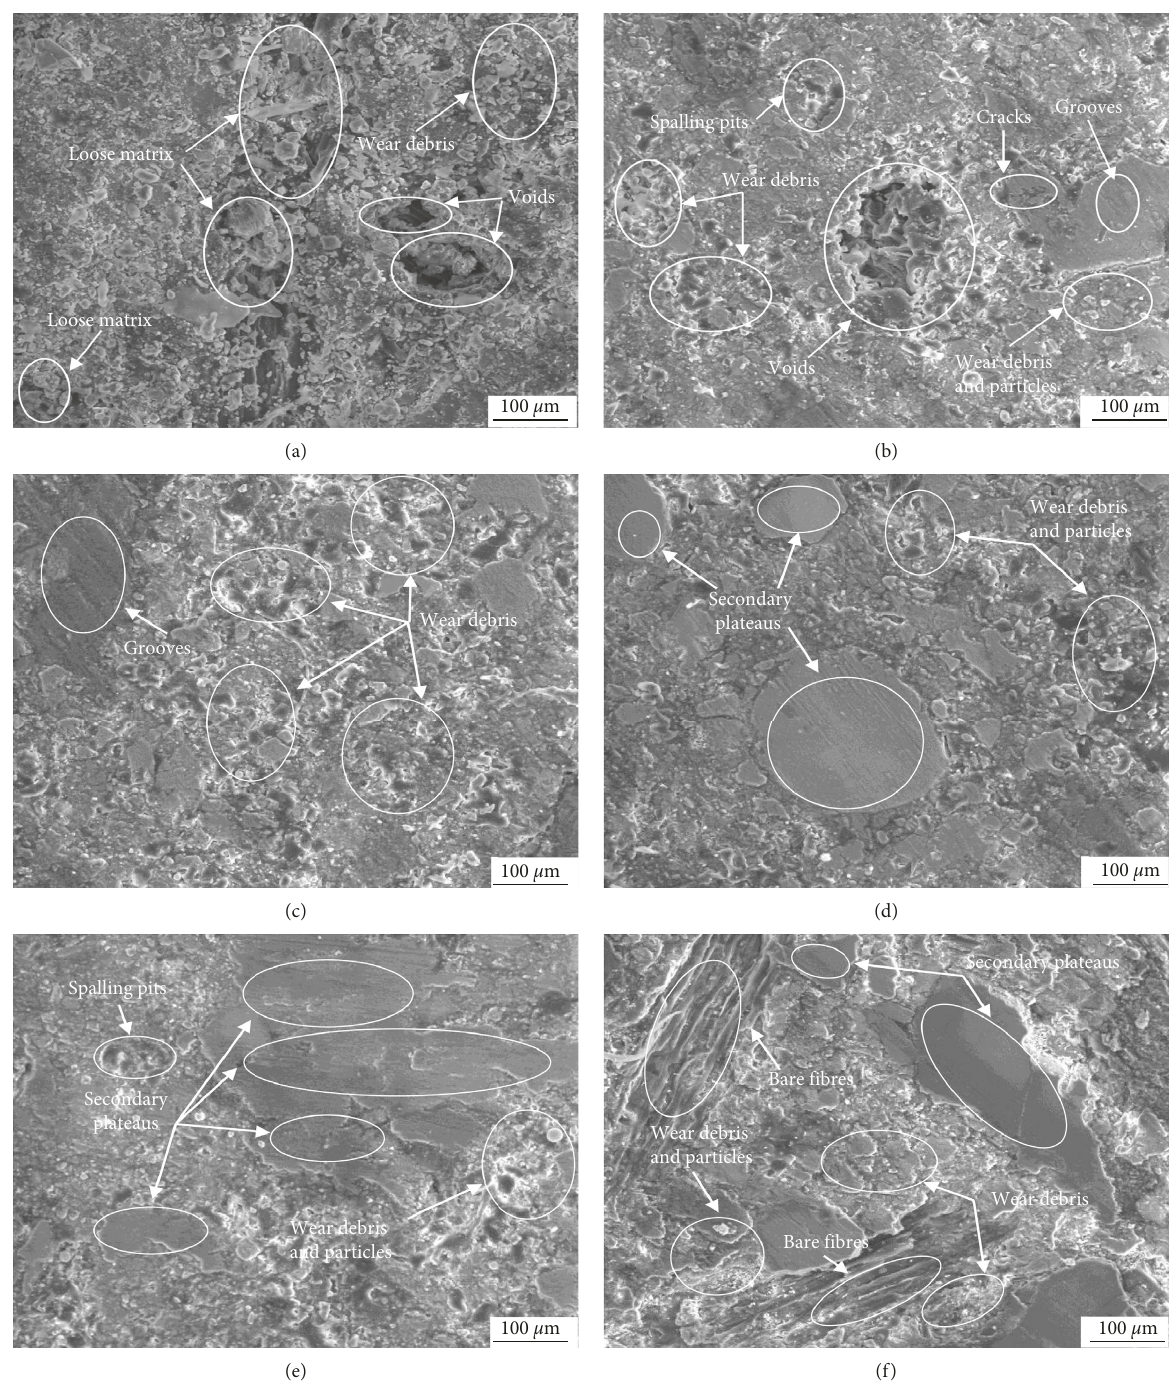
Figure 10: Worn surface micrographs of the composites. (a) FM-0. (b) FM-1. (c) FM-3. (d) FM-5. (e) FM-7. (f)